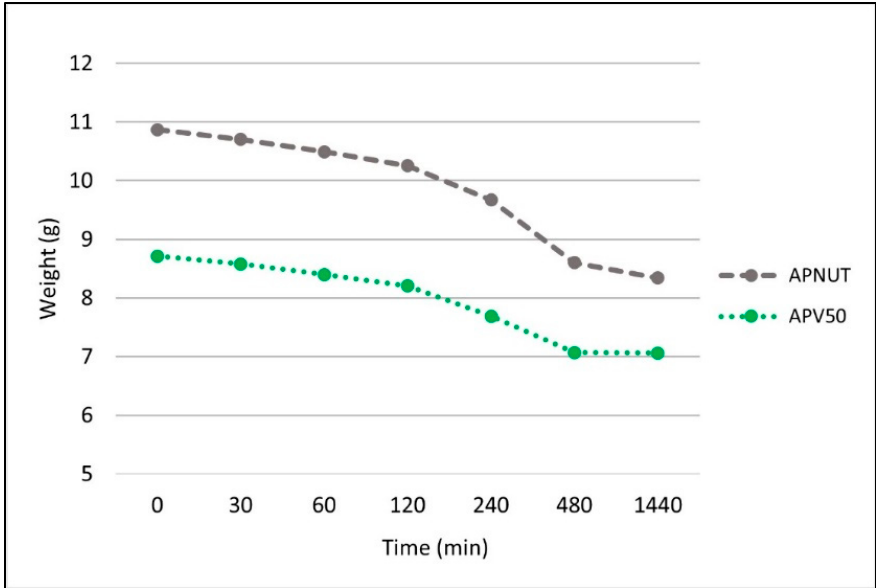
Figure 3. Water desorption from APNUT and APV50 in 24 h.